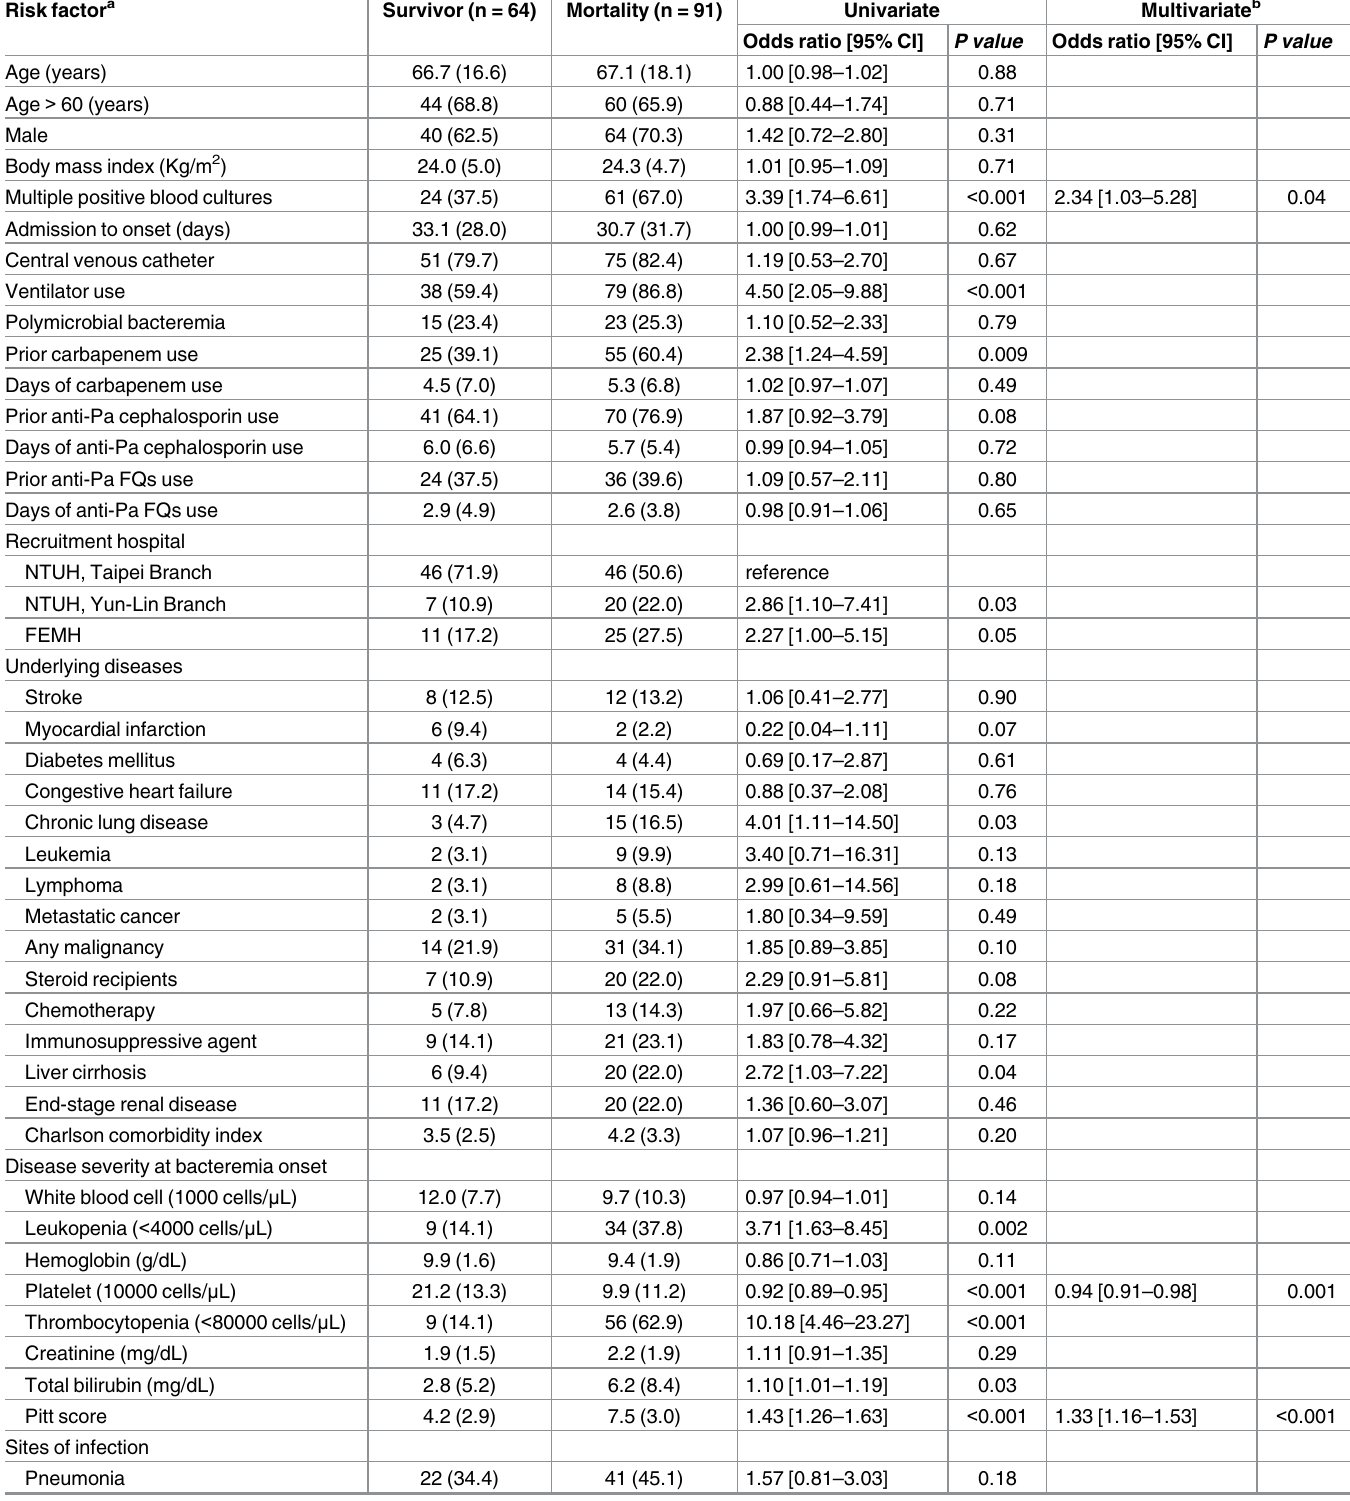
Table 2. Logistic-regression analysis for factors associated with 28-day